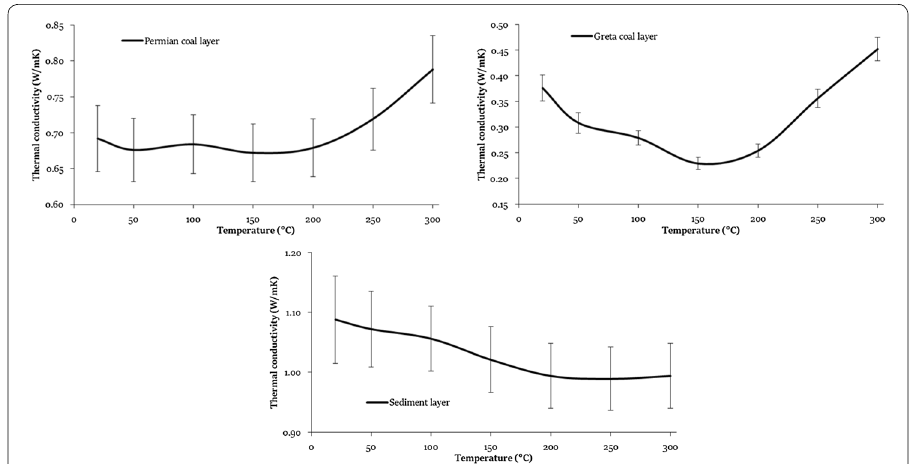
Fig. 8 Thermal conductivity of sedimentary/coal rocks. Sediment layers are an average value of Triassic Sydney Basin sediments—consisting of coastal samples such as conglomerates, muddy sandstone and medium-grained sandstone. Permian coal layer is an average of the Whittingham, Tomago and Newcastle coal measures (Volcanics layer is an artificial value adapted from Danis et al. (2012) models, values are listed in